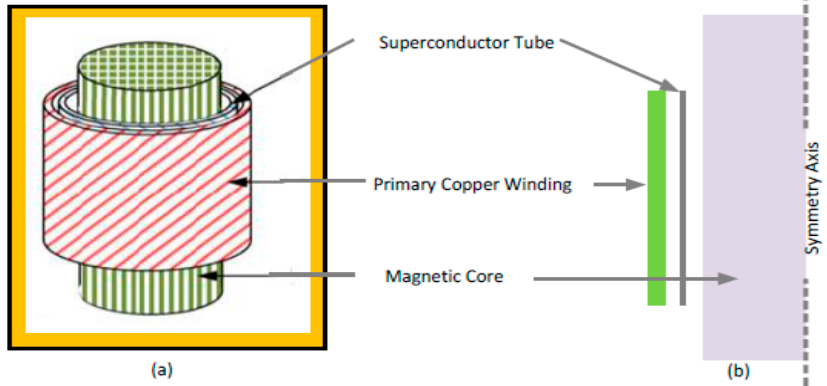
Figure 15. Magnetic Shield SFCL ( a ) Full structural view ( b ) Cross-sectional view.